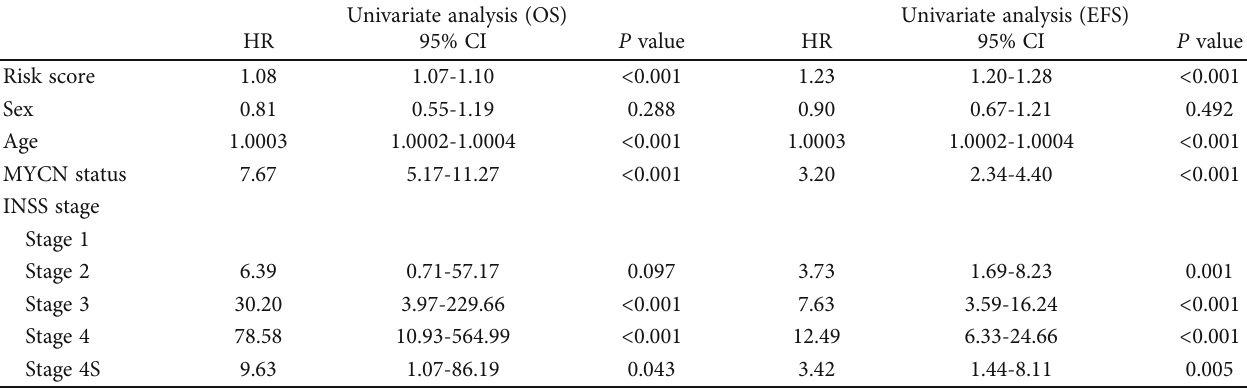
Table 3: Univariate Cox regression analyses for identifying prognostic clinical characteristics.